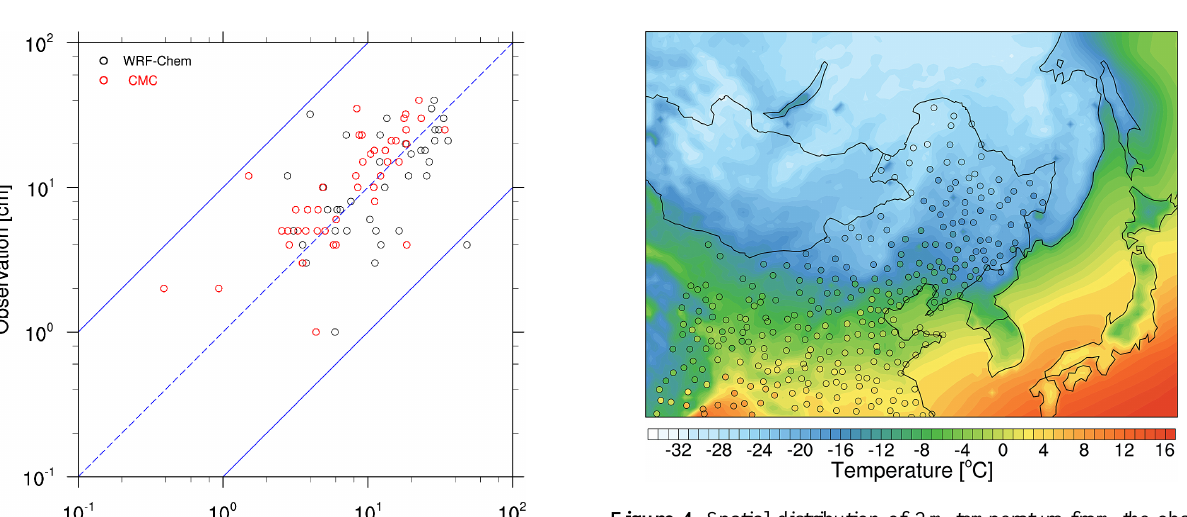
Figure 4. Spatial distribution of 2m temperature from the obser- vations (colored circle) and the corresponding WRF-Chem simula- tions over North China in January–February